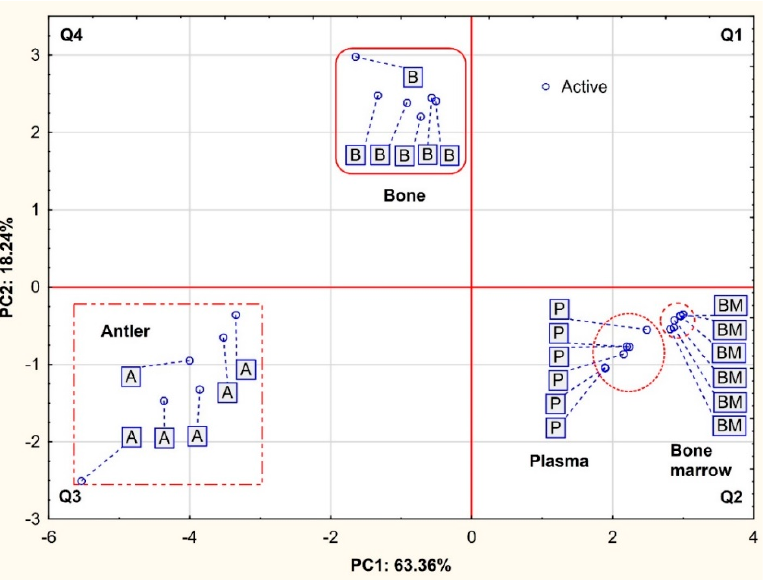
Figure 2. Projection of cases depending on the fallow deer tissues in the two-factor plane (PC1 × PC2).